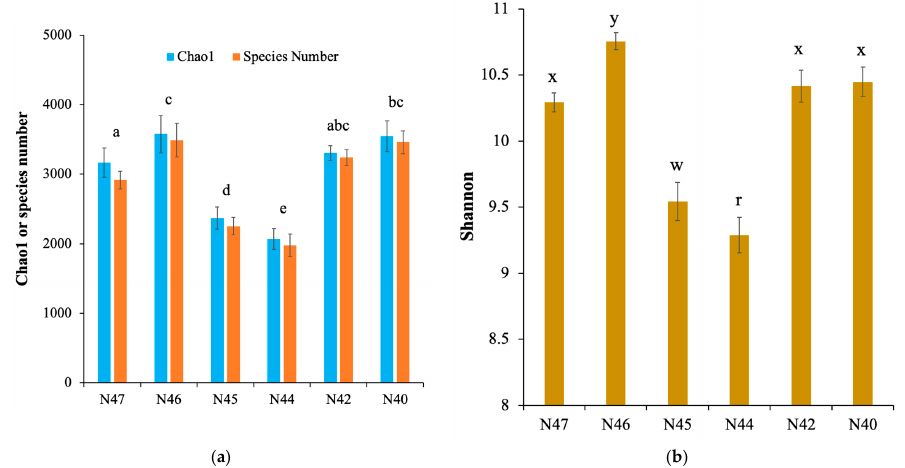
Figure 2. Bacterial community diversity in the saline–alkaline soil samples. ( a ) Bacterial species rich- ness, represented by species number, in each sample. ( b ) Bacterial diversity, indicated with Shannon index, in each soil sample. Letters indicate significant differences according to Student’s t -test.